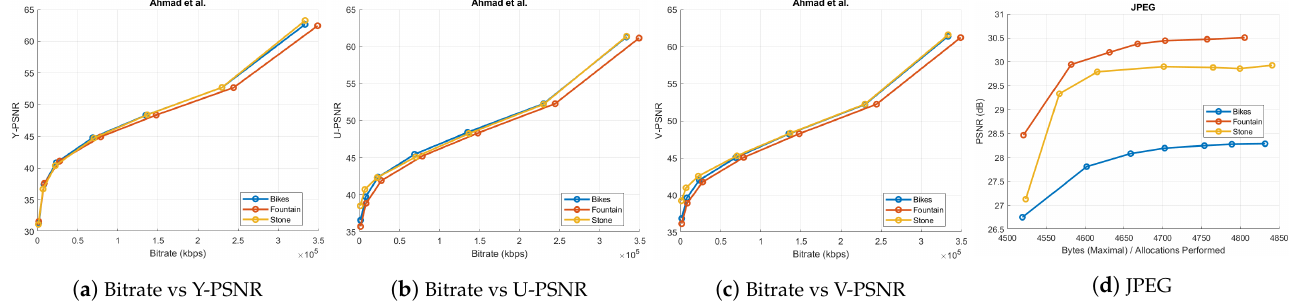
Figure 11. ( a – c ) The bitrate versus PSNR graphs of Ahmad et al. coding scheme for all three datasets; ( d ) graph depicting the maximal bytes per allocations performed against the PSNR for Bikes , Fountain-Vincent2 , and Stone-Pillars Outside datasets using the JPEG codec.